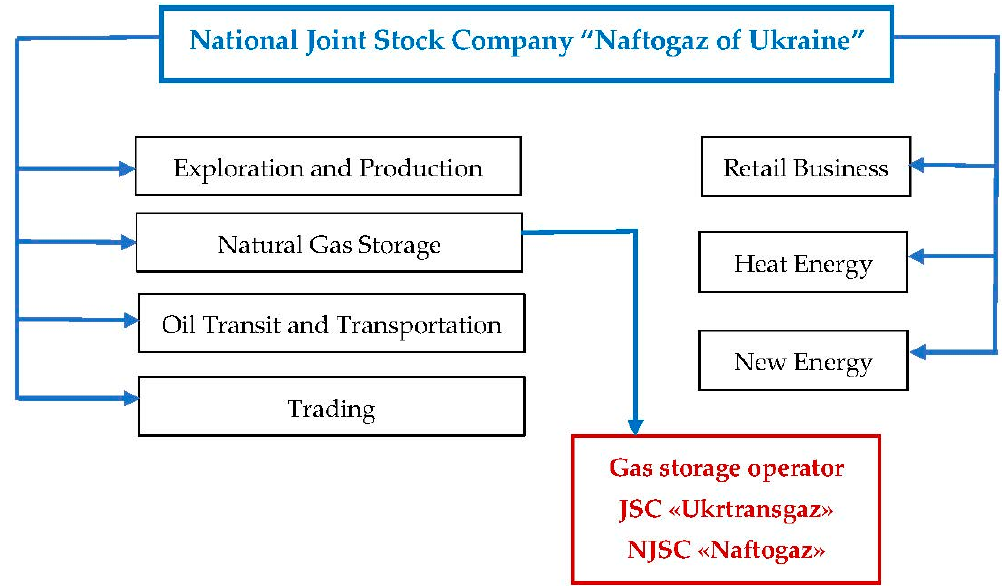
Figure 1. Naftogaz’s operations are managed by business divisions. Source: [43].